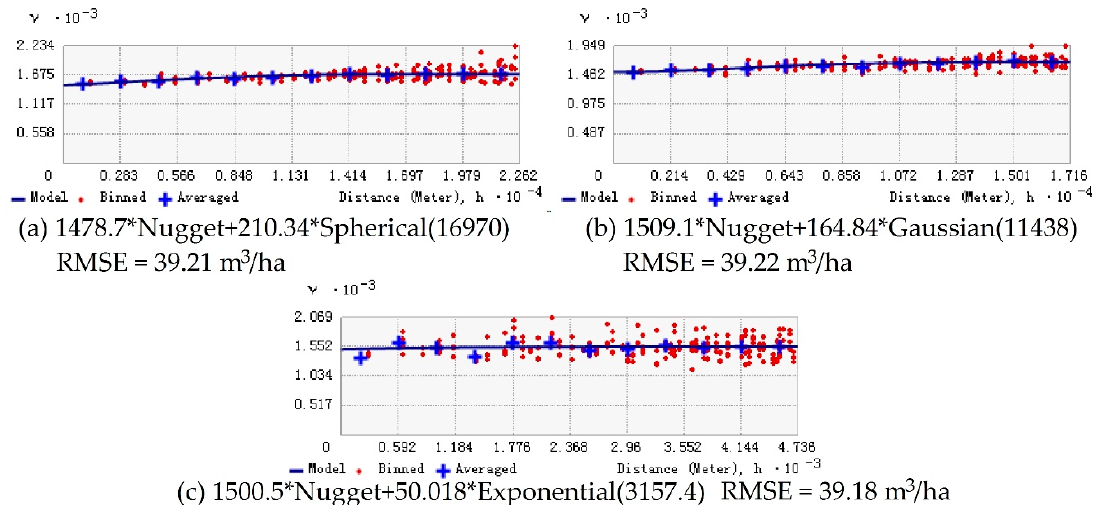
Figure 6. Experimental variograms and fitted models of residuals from SVR by ( a ) spherical, ( b ) Gaussian, and ( c ) exponential models.